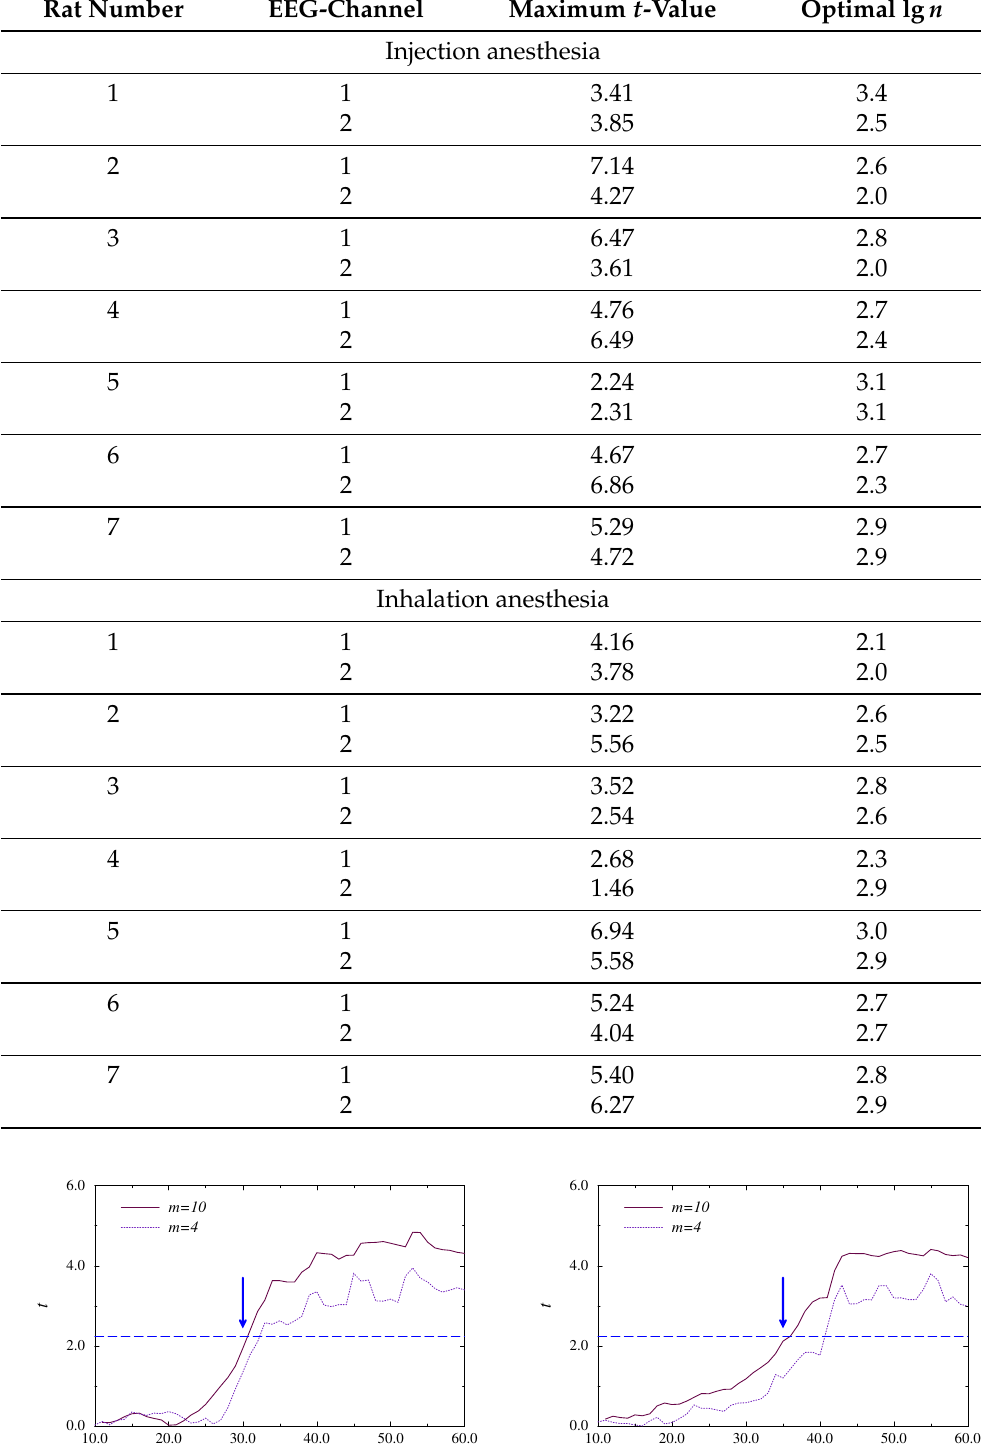
Table 1. The maximum t -value and the optimal scale range for individual records and both types of anesthesia.